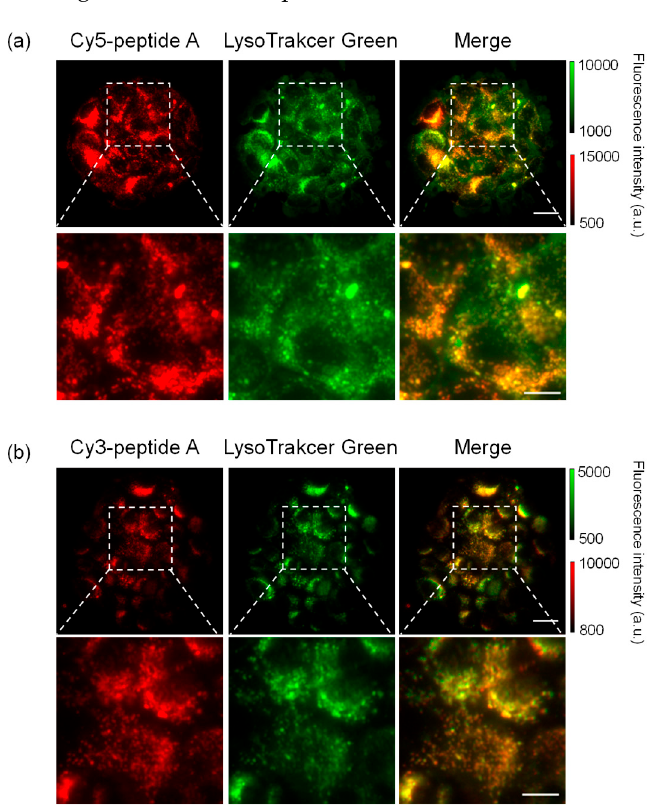
Figure 3. Colocalization of dye-peptide A and LysoTracker Green. ( a ) Cy5-peptide A, ( b ) Cy3-peptide A. Scale bar: 10 μ m, 5 μ m for magnified images. 7.